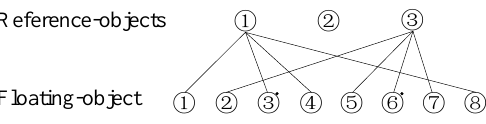
Fig. 3 An Example of Gravitation